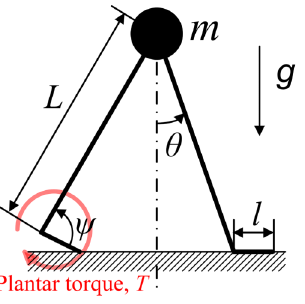
Figure 1. A schematic of the walking model. A point mass is restrained by rigid massless legs. The trailing ankle is actuated as a pre- loaded spring released at the beginning of double stance. The hip joint and the leading ankle do not exert any torque.